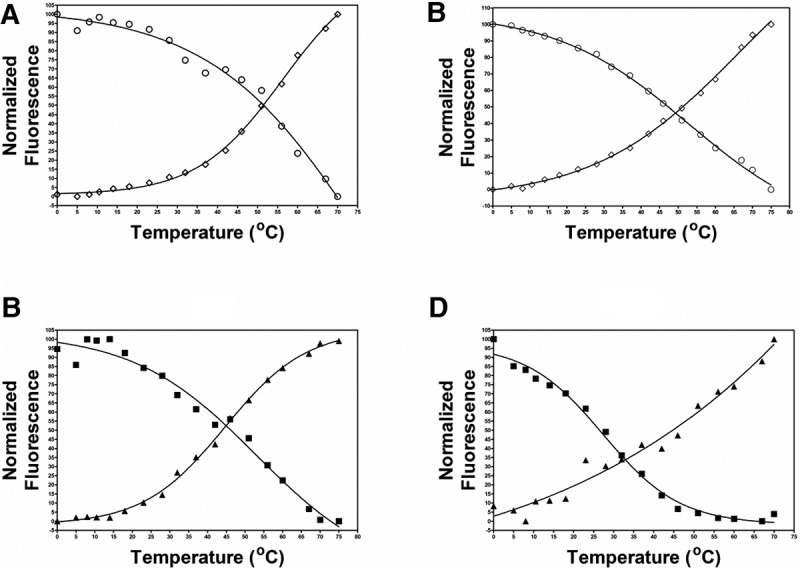
Thermal denaturation analysis of 2-AP substituted RNA hairpins. (A) (○) CPGAUGAAAAUCG, (◊) CPGAUGAAAAUCUG. (B) (○) CGAUGAAAAUCPG, (◊) CUGAUGAAAAUCPG. (C) (▪) CPAGAUGAAAAUCUG, (▴) CAPGAUGAAAAUCUG. (D) (▪) CUGAUGAAAAUCAPG, (▴) CUGAUGAAAAUCPAG. Fluorescent intensity values were normalized to emission from pentamer control RNA sequences at each measured temperature.